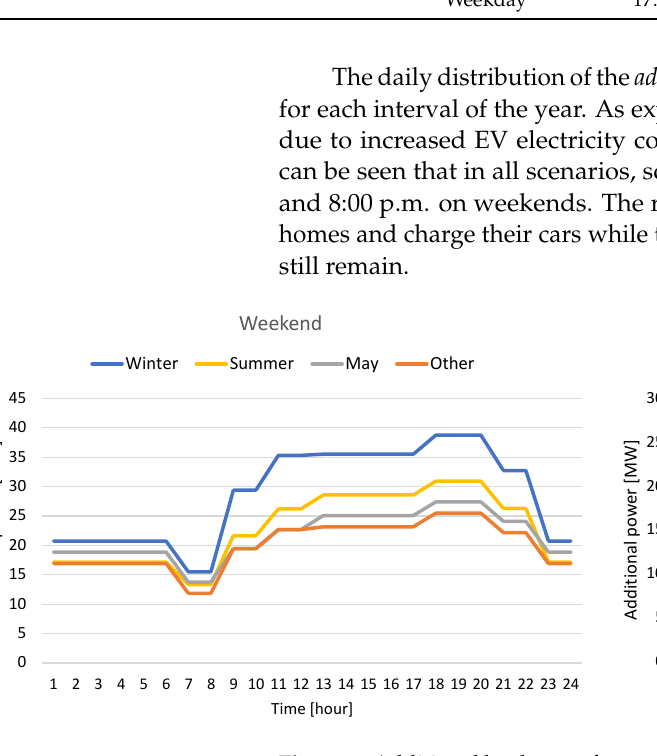
Figure 7. Additional load curve for scenario 1 ( high-end gasoline rest stops ). Winter = November–March, summer = June–August, and Other = April, September, and